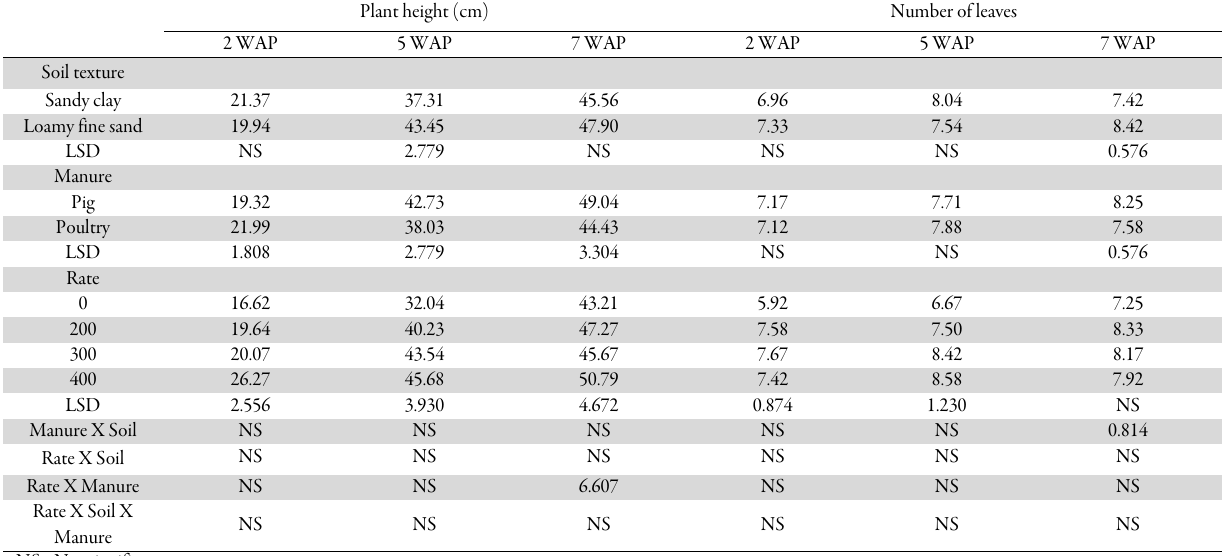
Table 3. Effect of soil texture and rates(g pot -1 ) of poultry and pig manure on plant height and number of leaves of tiger nut plants at 2,5 and 7 weeks after planting (WAP). Values are a mean of 5 plants